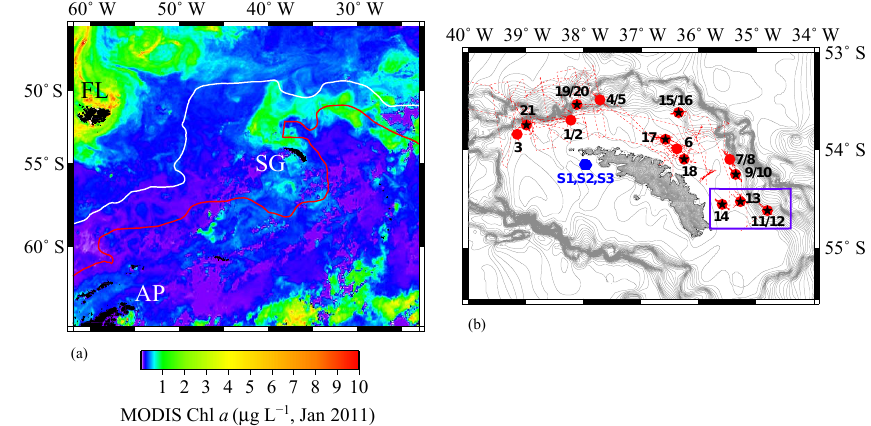
Figure 1. (a) Locations of Falkland Islands (FL), South Georgia (SG), and Antarctic Peninsula (AP) in the Atlantic sector of the Southern Ocean. South Georgia is located between the Antarctic Polar Front (PF, white line) and the Southern Arctic Circumpolar Current Front (SACCF, red line). The colour bar represents the Chlorophyll a (Chl a ) content recorded by the MODIS satellite in January 2011. (b) The region around SG and the OTE (black stars) and SAPS sampling sites (red points) visited during JR247. The red dashed line illustrates the cruise track of JR247. The three sediment sampling sites visited during JC055 (S1, S2, and S3) are shown by blue hexagons. The purple box indicates the W–E transect from shelf site #14 via site #13 to the shelf edge site #11/12. The ocean bathymetry of the region was plotted using the GEBCO bathymetric data set. The shelf of South Georgia is between 100 and 250m deep and extends about 30 to 100km (shelf edge indicated by high density of